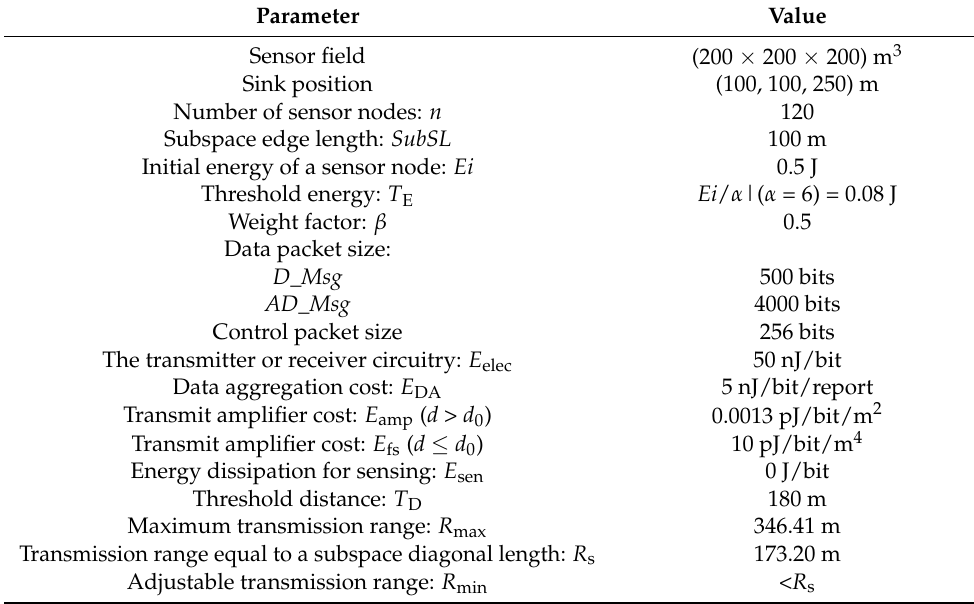
Table 2. Simulation parameters